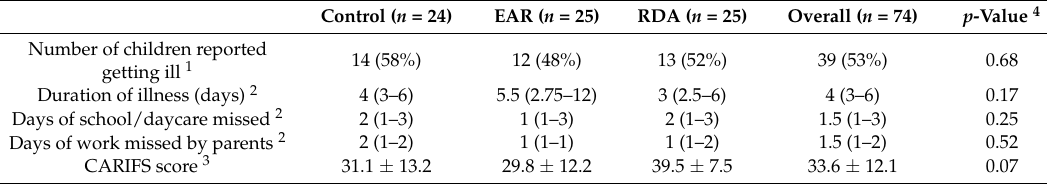
Table 2. Illness characteristics of children over 12 weeks in the